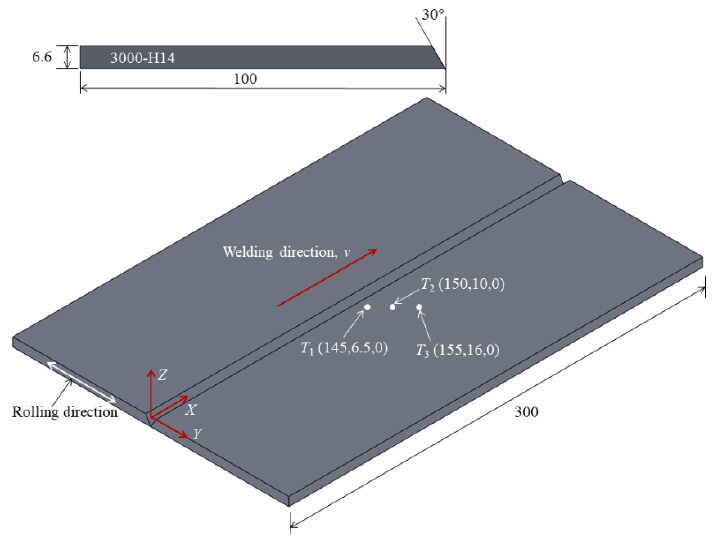
Table 1. Chemical composition of the materials used (weight percent) [2,16].